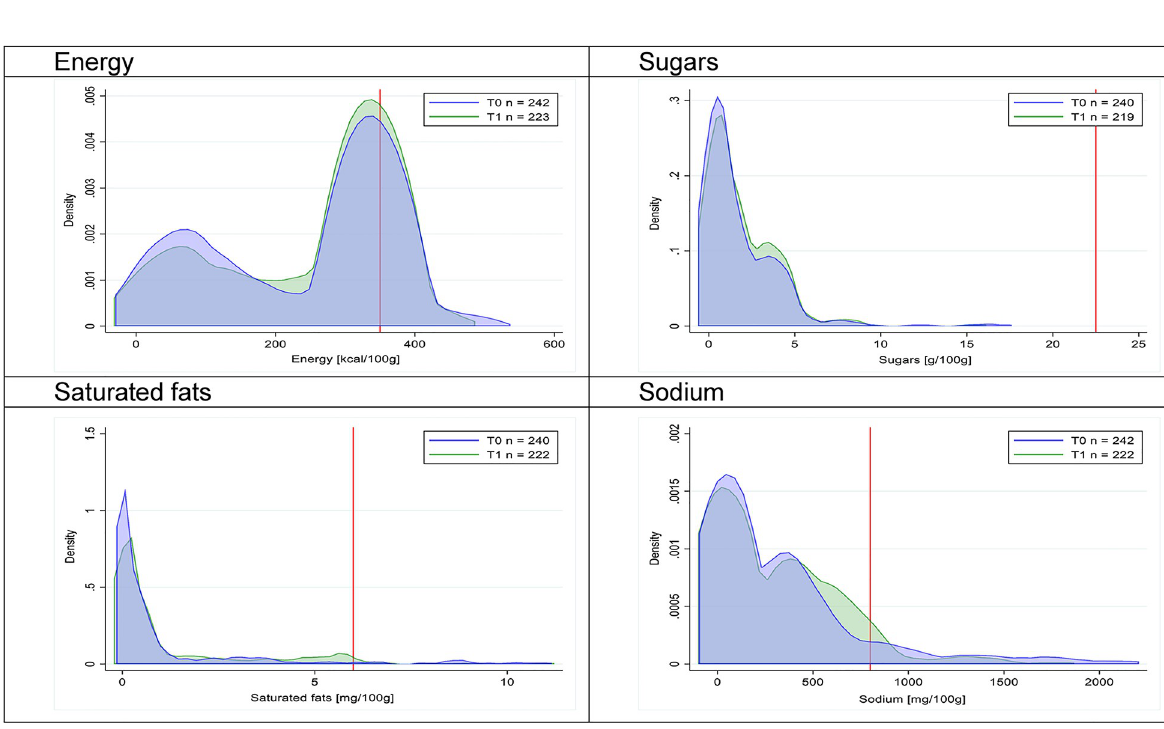
Fig 14. Density curves for the amount of energy and nutrients of concern in ready-to-eat meals, cross-sectional samples. The blue line represents the distribution in T0 (preimplementation), the green line represents the distribution in T1 (postimplementation), and the red line represents the cutoff for the amount of energy or nutrients of